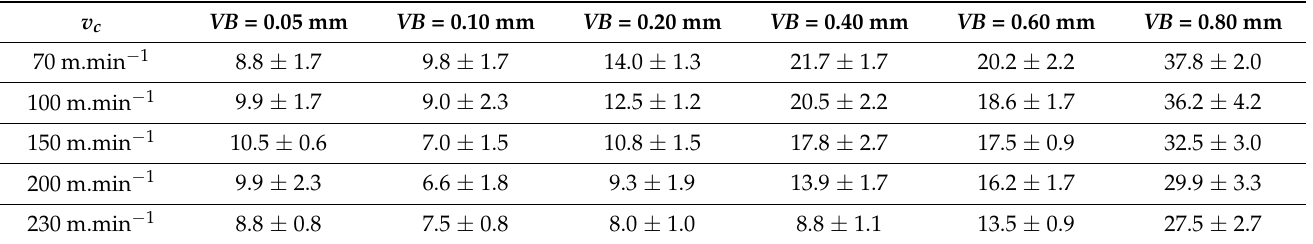
Table 4. Thickness of HAZ as a function of cutting speed and flank wear VB (thickness of HAZ in µ m).